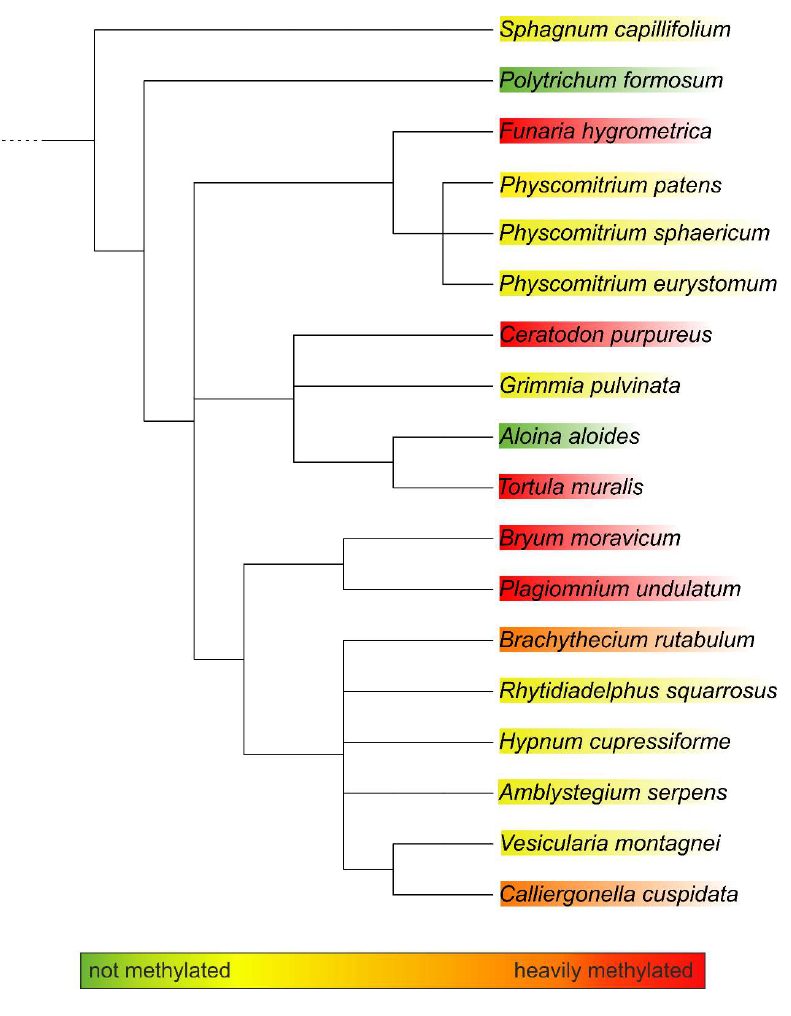
Figure 3. Phylogenetic tree of the analysed moss species as generated with PhyloT. The degree of methylation is indicated by the colour code. 3.3. Structural Analysis of The Main Glycans from Funaria Hygrometrica and Plagiomnium Undulatum For structural analysis, the glycomes of F. hygrometrica and P. undulatum were frac- tionated with HILIC-HPLC to purify the doubly methylated MGnXF from F. hygromet- rica and the doubly methylated MMXF from P. undulatum. The fractions containing mainly the glycans of interest were then hydrolysed, reduced and peracetylated before loading them on a GC-MS. For F. hygrometrica one part of the sample was also